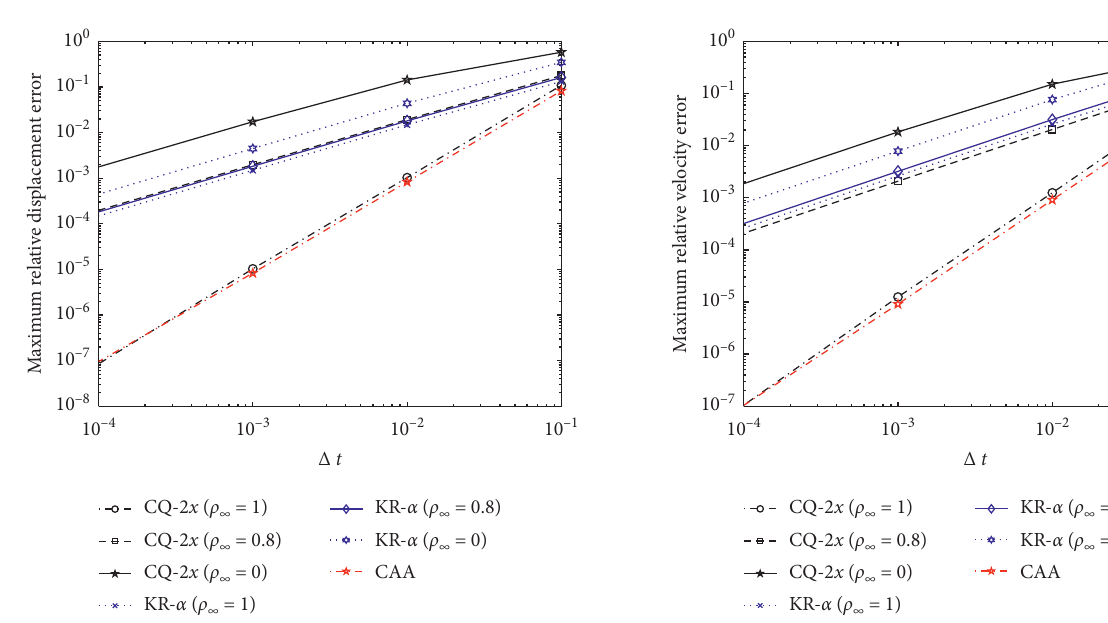
Figure 7: Convergence rate of CQ-2 x assessed in terms of the maximum relative displacement error.